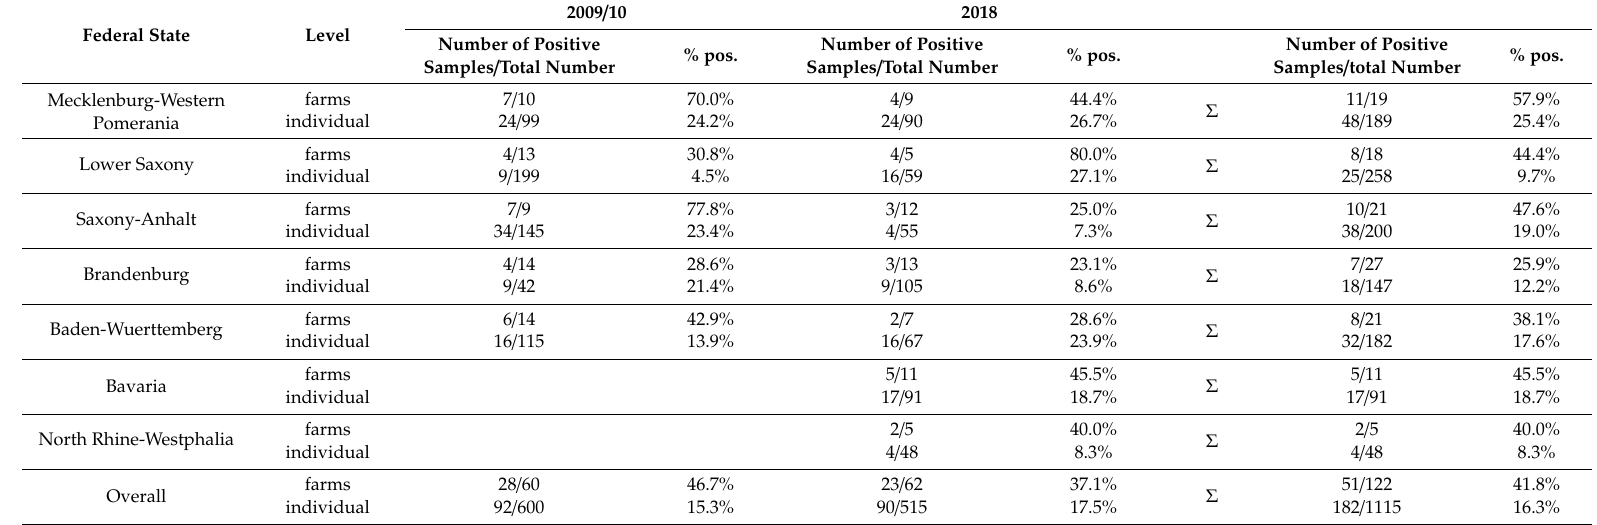
Table 1. Number of farms and individual animals tested per German federal state and percentage of farms and animals that tested positive for antibodies against APPV.